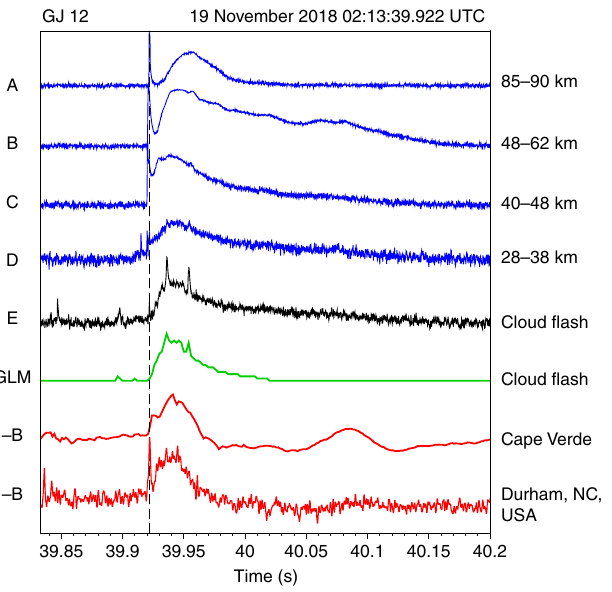
Fig. 6 The brightness evolution of sections of gigantic jet 12 compared to magnetic fi eld recordings and the parent cloud fl ash. Altitude sections of the jet are represented by A – D. Brightness is scaled to avoid overlap between curves and enhance weaker features in D and E. Cloud brightness (E) has been recorded by the high-speed camera and by the Geostationary Lightning Mapper (GLM) on the GOES-16 satellite. The bottom rows show the Extremely Low Frequency magnetic fi eld waveforms from Cape Verde (north-south component) and Duke University (east-west component) orthogonal to the event